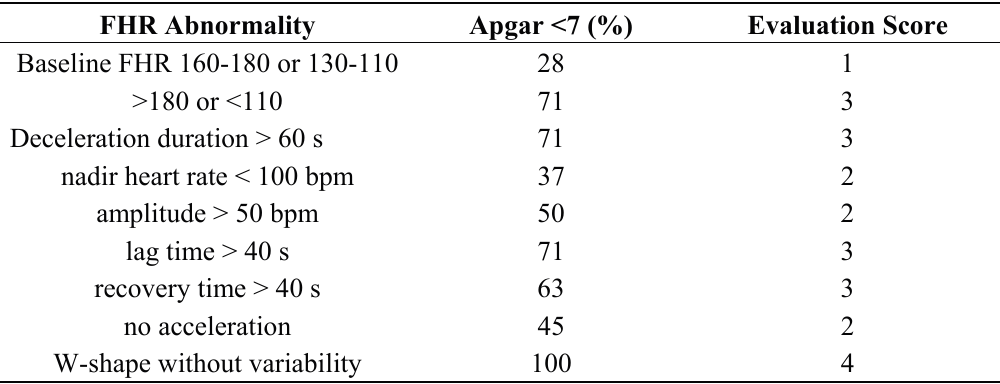
Table 1. Evaluation scores to be given each FHR abnormalities